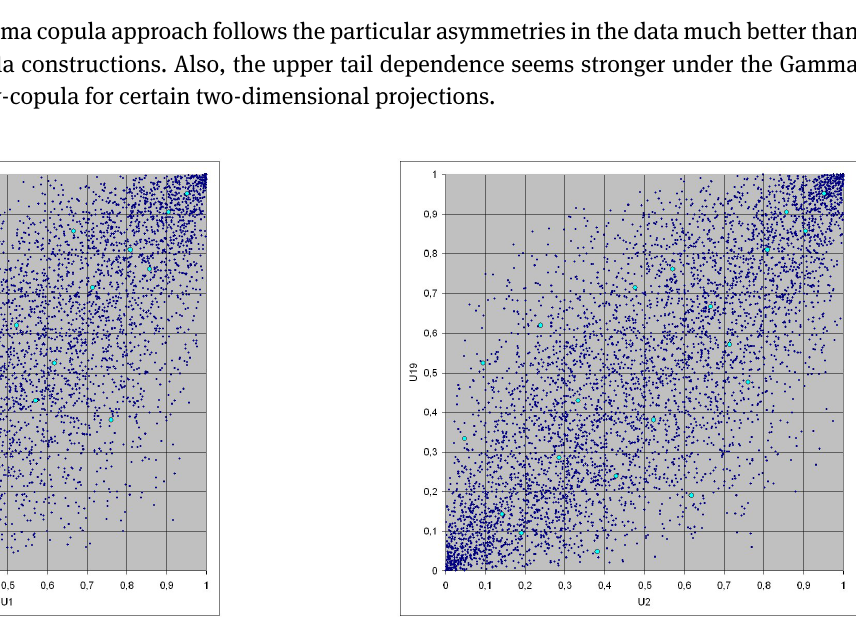
Figure 32: Gaussian copula,